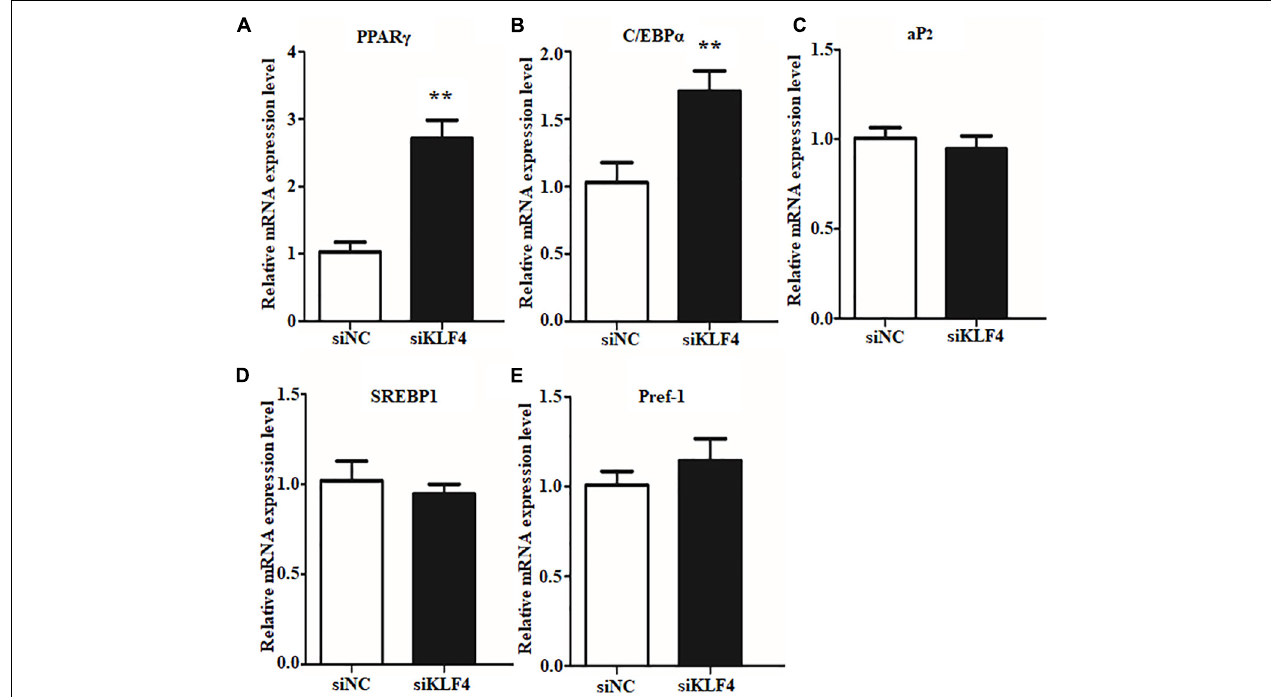
FIGURE 3 | Knockdown of KLF4 expression upregulates the mRNA expression of C/EBP α and PPAR γ . The mRNA levels of PPAR γ (A) , C/EBP α (B) , aP2 (C) , SREBP1 (D) , and Pref1 (E) in control and KLF4 siRNA-treated intramuscular adipocytes. * p < 0.05, ** p < 0.01 versus negative control (siNC) groups. The data are presented as the mean values ± SD. Each experiment was performed at least in triplicate, producing consistent results. * p < 0.05, ** p < 0.01.